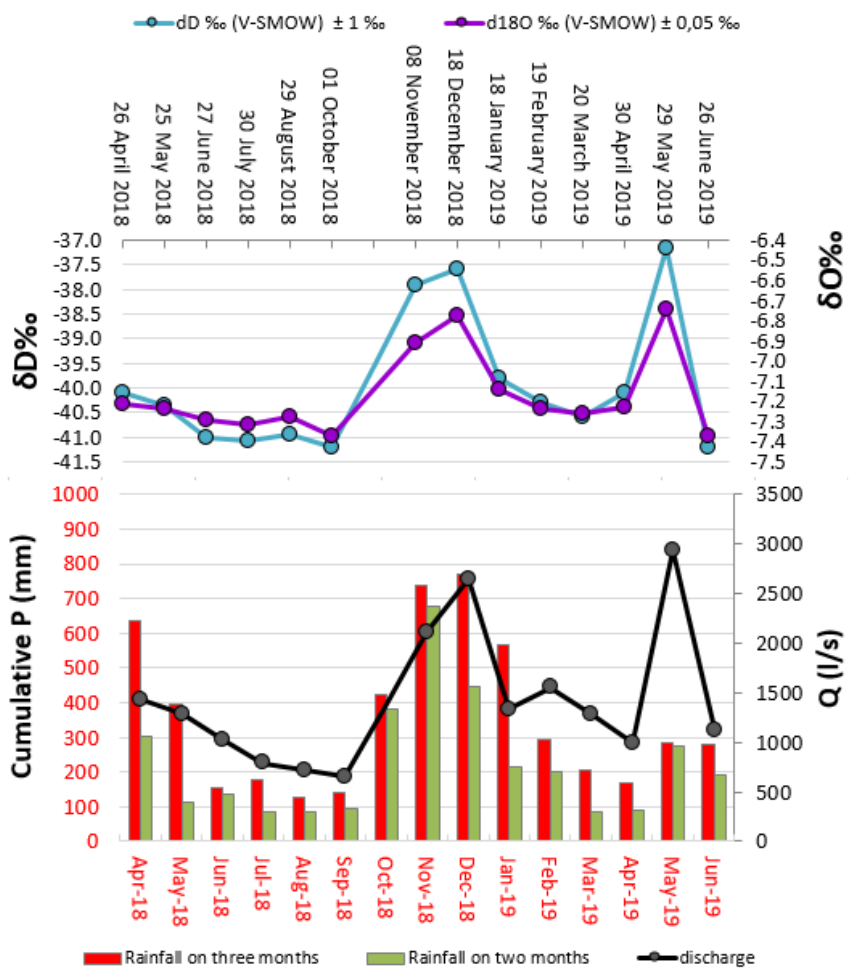
Figure 6. Comparison between spring discharge values (Q) and δ 2 H‰ and δ 18 O‰ values and monthly cumulative rainfall data (Esperia Pluviometric Station, 302 m a.s.l.) during the study months.